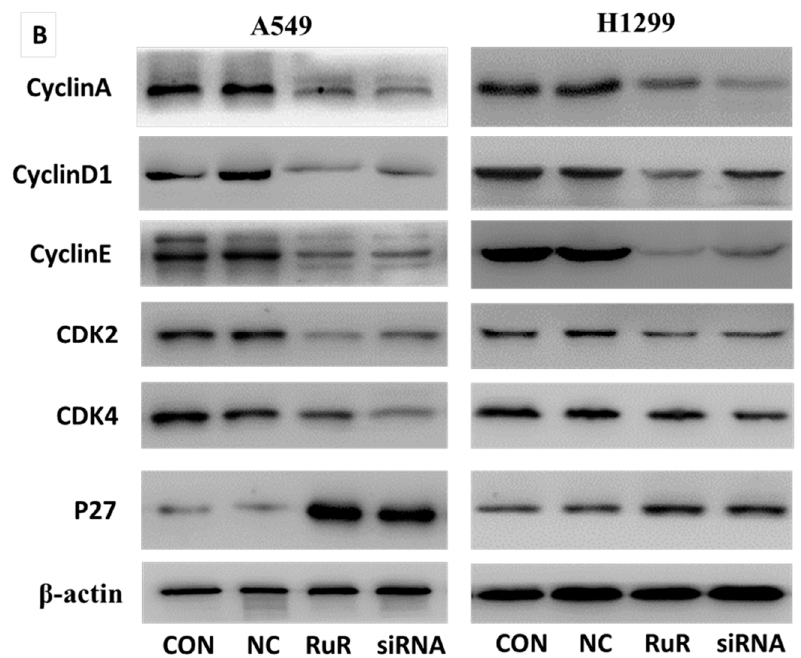
Figure 5. The effects of TRPV3 on A549 and H1299 cell cycle kinetics. Cell cycle phase was determined from the incorporation of propidium iodide (PI). Cells were analyzed 24 h after plating by flow cytometry ( A ); Western blot analysis of a series of cell cycle related factors showed the protein levels were changed ( B ). All data were expressed as mean ± SD of triplicates. # p < 0.05 compared with control group; * p < 0.05 compared with NC group.